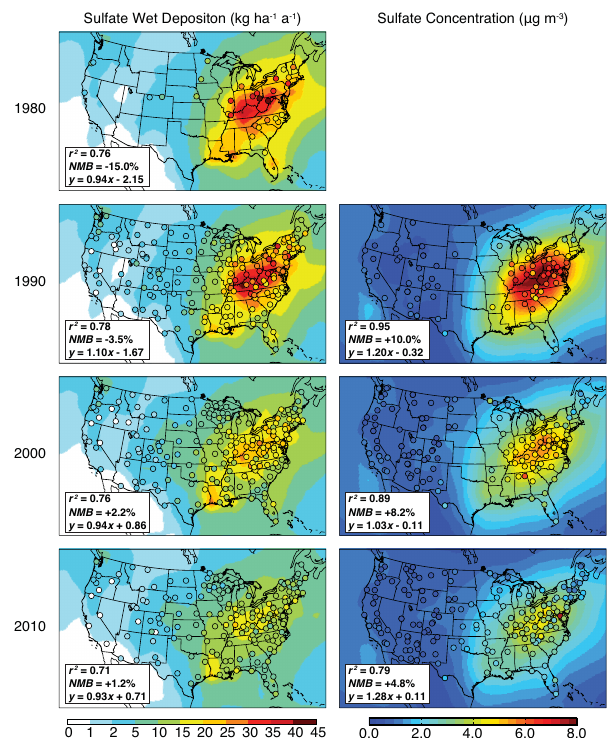
Fig. 2. Sulfate wet deposition fluxes (kgha − 1 a − 1 , left) and sul- fate concentrations in surface air (µgm − 3 , right). Observations (circles) are 3-year averages for 1979–1981 (wet deposition only), 1989–1991, 1999–2001, and 2008–2009. GEOS-Chem model val- ues (background contours) are from decadal time slice simulations with 1980, 1990, 2000, and 2010 emissions. Reduced major axis linear regressions between model and observations are shown inset for each map along with the coefficient of determination ( r 2 ) and normalized mean bias